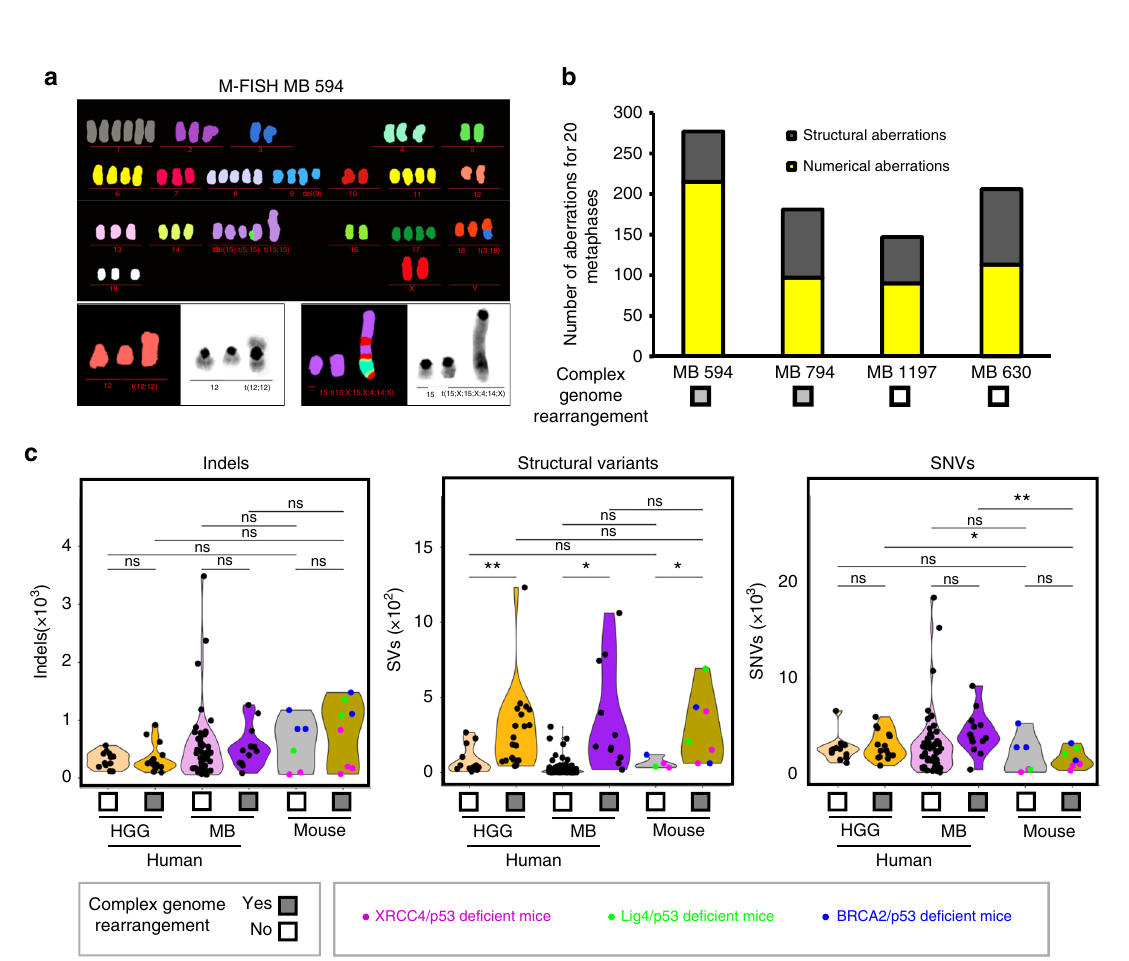
Fig. 2 Karyotyping of the murine tumors and comparison of the global genetic landscapes with human tumors. a Complex genome rearrangements are associated with increased chromosome numbers and with structural aberrations. Left panel, M-FISH analysis of medulloblastoma cells from a XRCC4/p53- de fi cient mouse. b Quanti fi cation of the structural and numerical aberrations detected by M-FISH analyses for medulloblastoma cells derived from four Xrcc4/p53-de fi cient mice. c Indel, structural variant and SNV burdens by whole-genome sequencing in human high-grade gliomas (HGGs, n = 32) and medulloblastomas (SHH MBs, n = 68) as compared to murine HGGs and MBs ( n = 14, colored according to the genotypes). Human SHH MBs with TP53 mutations all show complex genome rearrangements (dark purple) * p < 0.05, ** p < 0.01, beta-regression